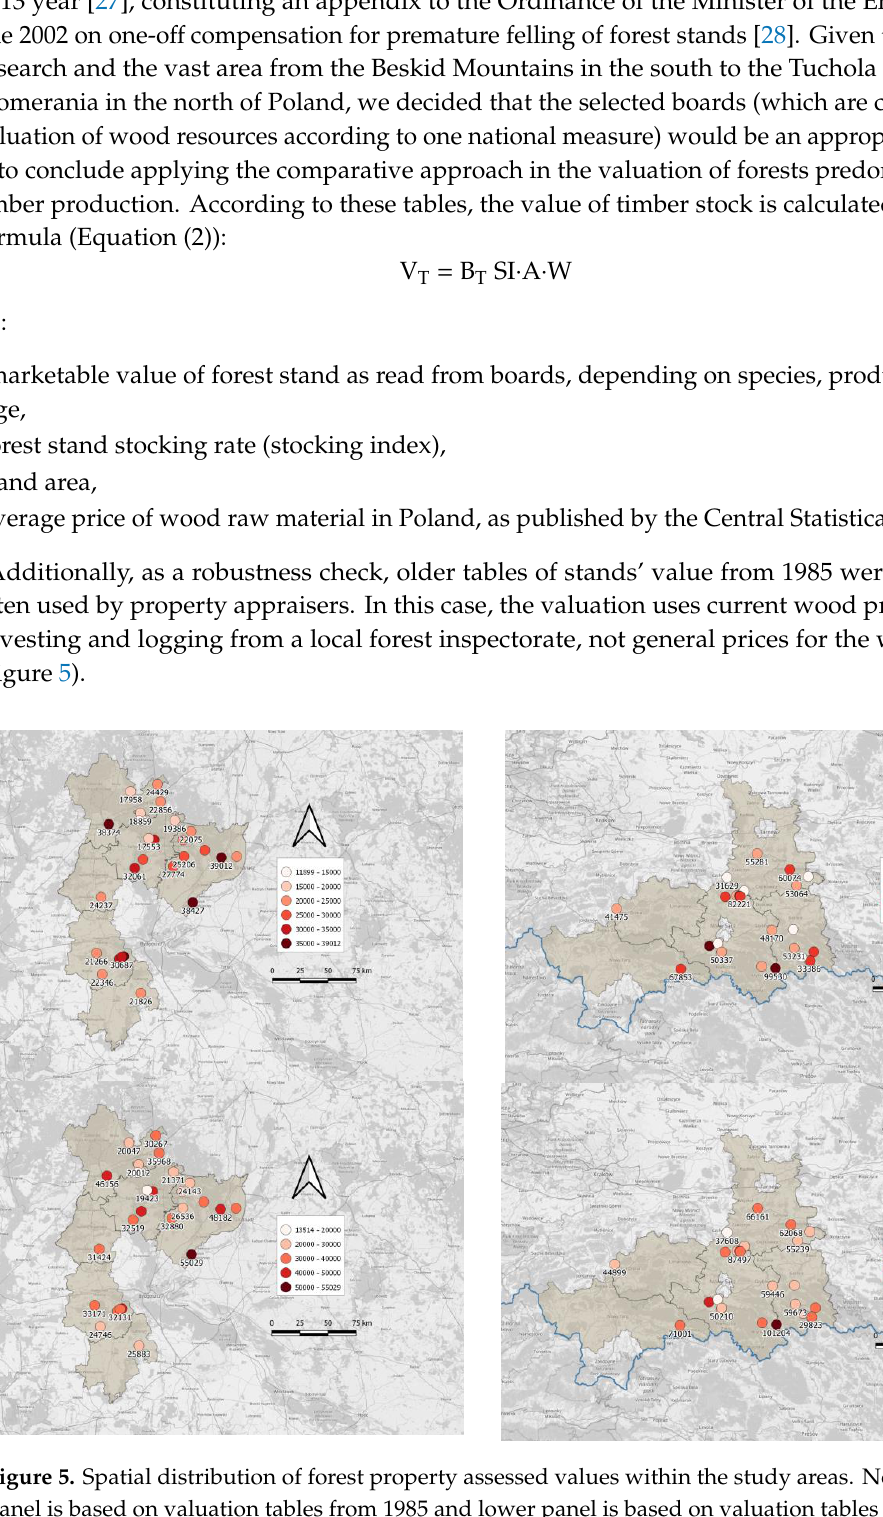
Table 2. Descriptive statistics of forest property by dominant tree species in the stand.